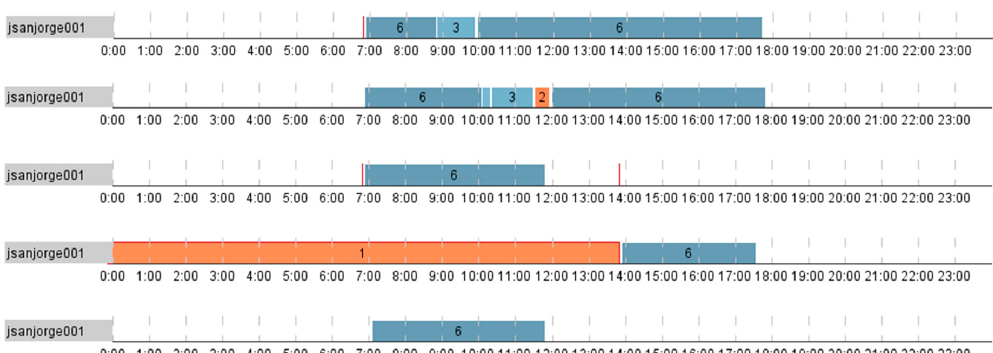
Figure 13. The BandView visualization of the daily routes of the Executive department representative.